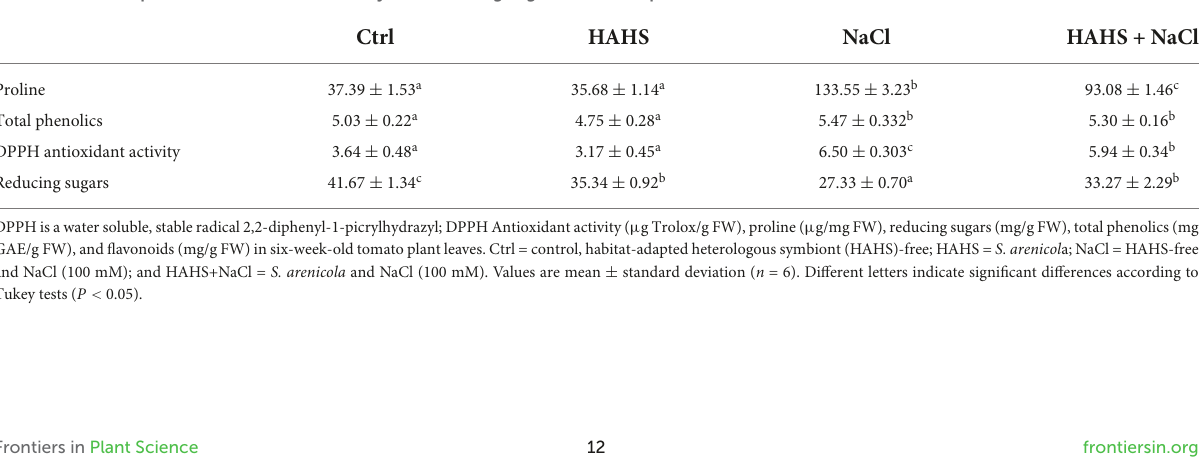
TABLE 2 Proline, phenolics, antioxidant activity, and reducing sugars in tomato plant